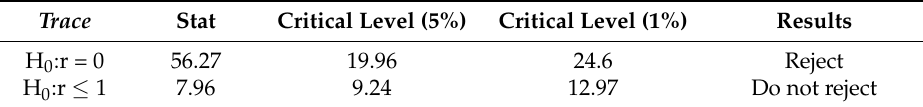
Table 3. Cointegration tests: trace.